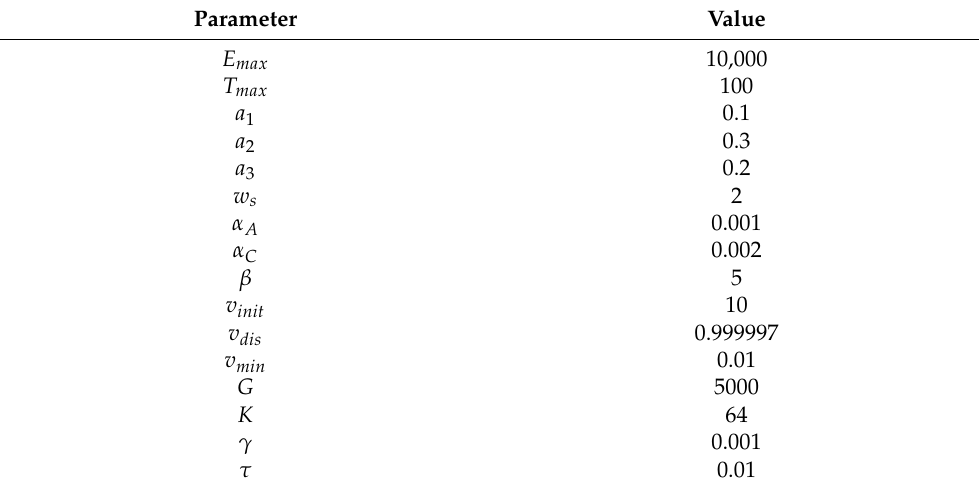
Table 2. Training